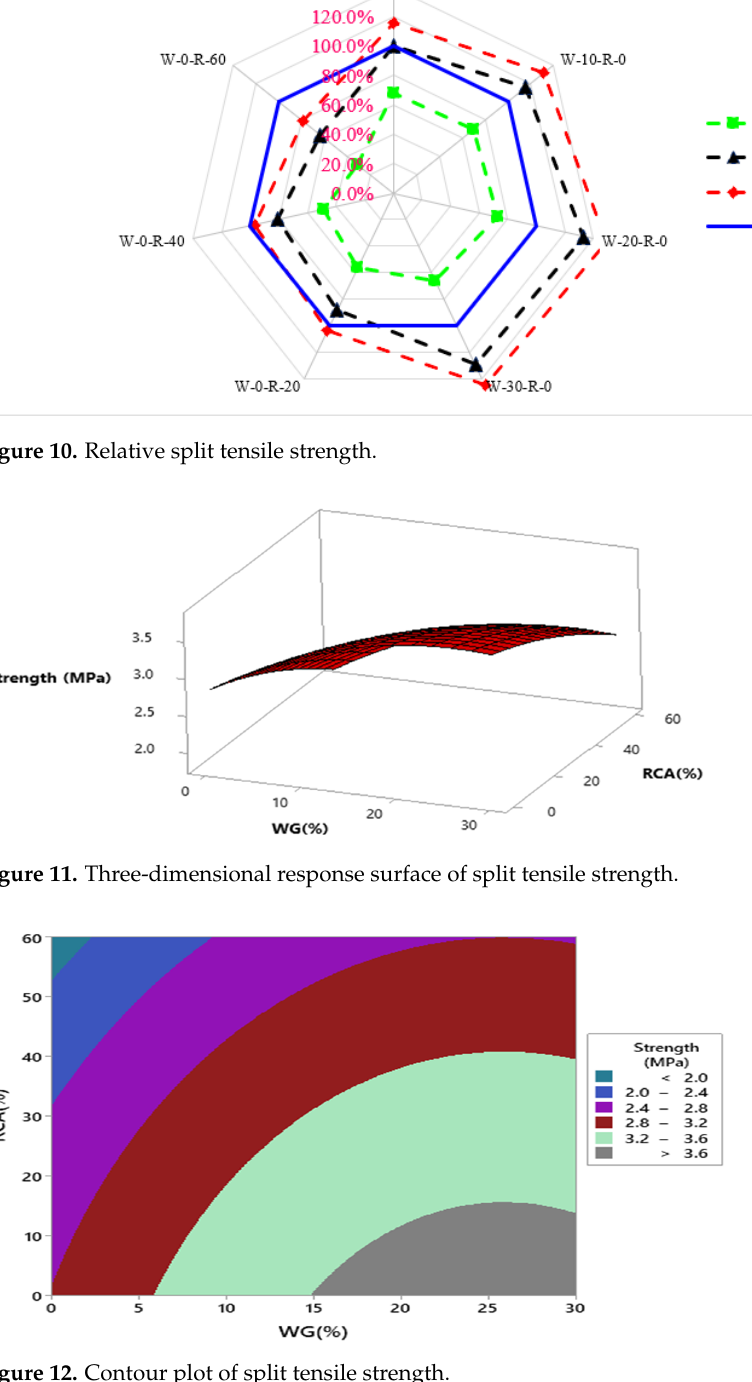
Figure 13. Correlation between compressive and split tensile strength (7, 28 and 56 days).